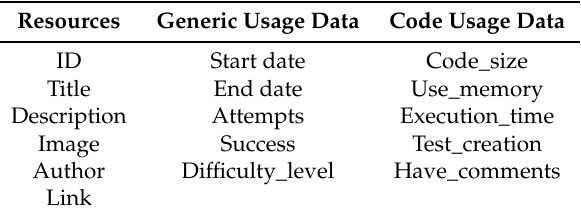
Table 1. PROud data